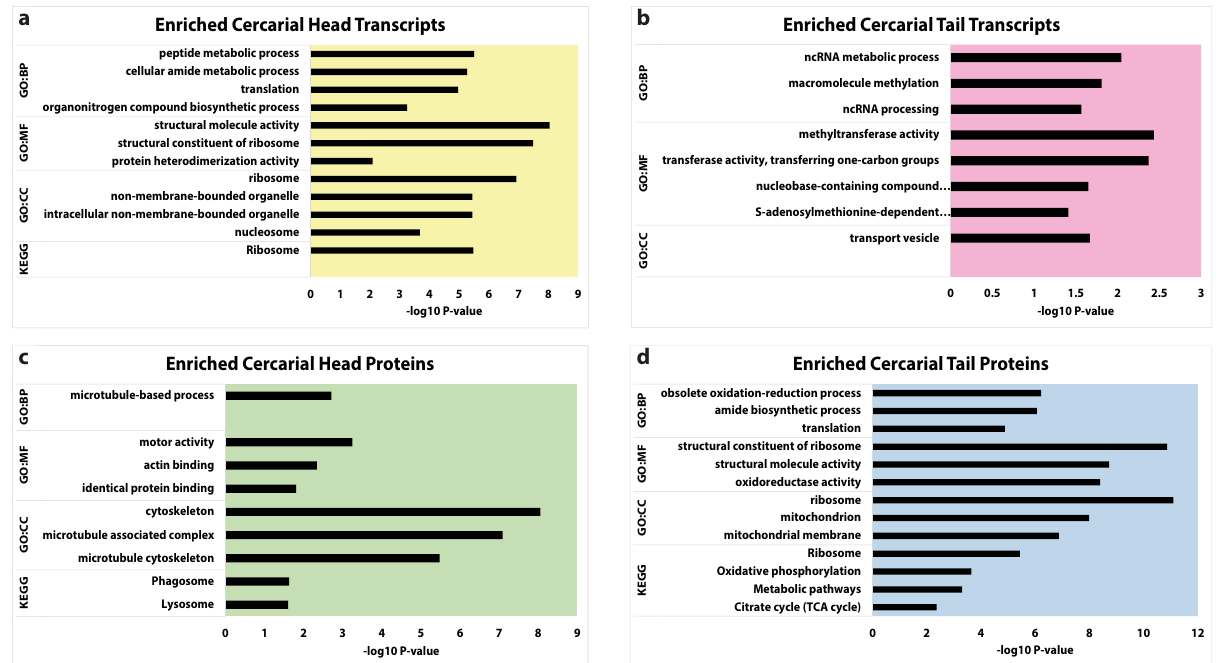
Fig. 3 GO analysis of overexpressed transcripts and proteins from cercarial heads and tails. Cercarial Heads have signi fi cant enrichment for ribosomal transcripts and structural proteins. Cercarial tails have signi fi cant enrichment of ribosomal and mitochondrial proteins. All data shown represent enriched categories of differentially expressed genes via GO analysis. Panels a and b show enriched transcript categories in cercarial heads and tails. c , d show enriched protein categories from cercarial heads and tails. All supporting data is contained in Supplementary Data